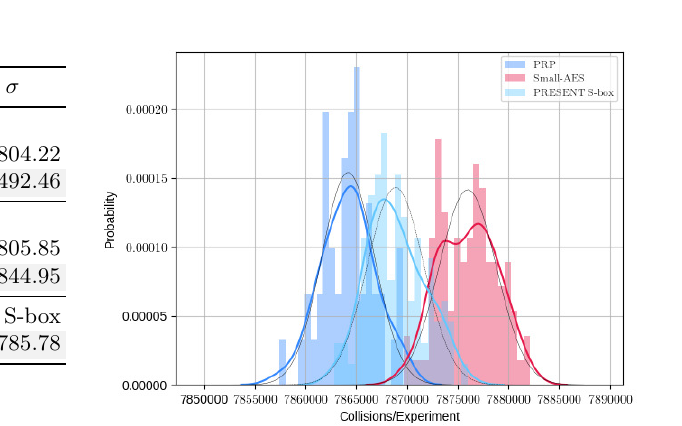
Figure 3: Means and standard deviations for the number of pairs that collided in at least one inverse diagonal for our five-round truncated-differential with Small- AES . Each experiment employed 100 random independent keys and 2 30 random δ -sets. Speck-64-96 has been used as PRP π . We compare to Small- AES with the PRESENT